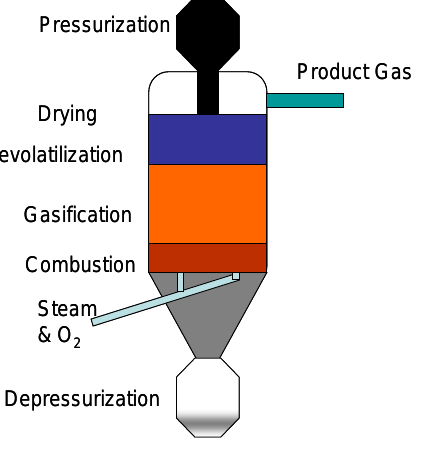
Figure 2 Typical Configuration for Dry